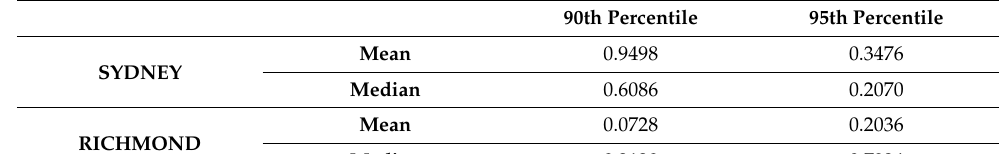
Table 3. p -values from the permutation testing of differences in the average number of summer days above the 90th and 95th percentiles for Sydney and Richmond. Tests were conducted using 5000 resamples. Table 4. Total number of days above the 90th and 95th percentile for Sydney and Richmond. The percentile values are computed using the first climate period.